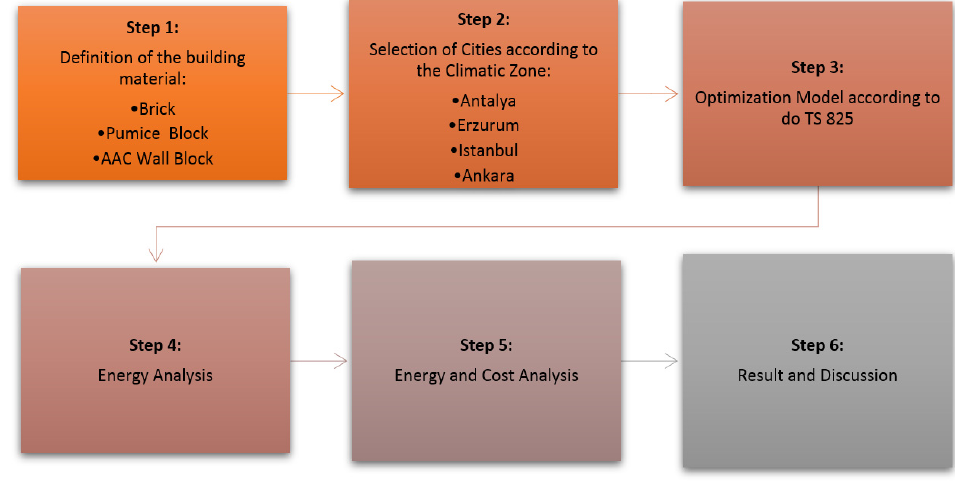
Figure 1. Methodological framework.